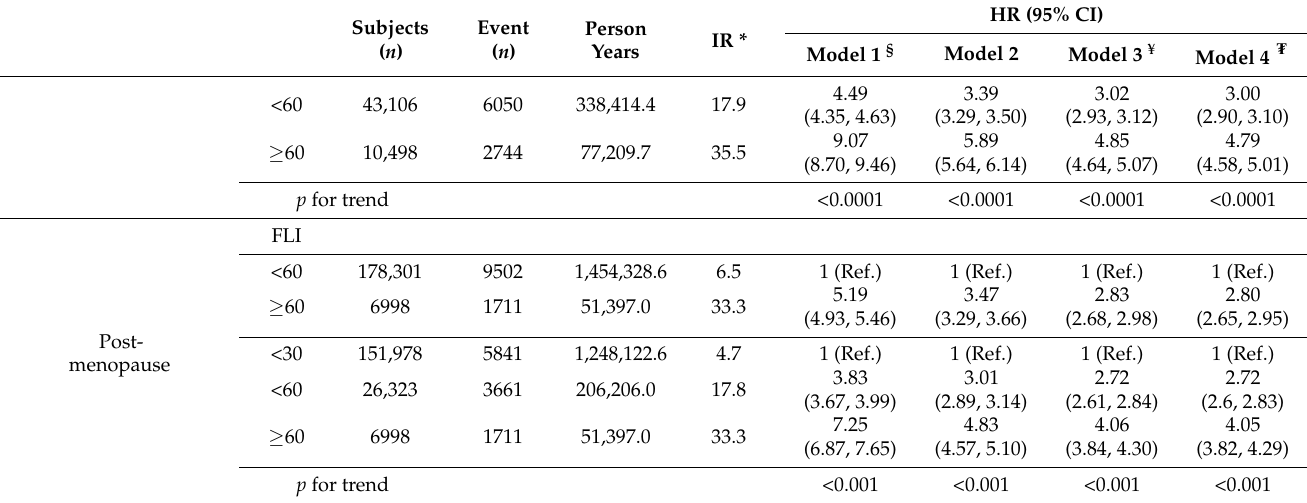
Table 3. Associations between fatty liver index and type 2 diabetes mellitus risk by menopausal Table 5. Cont.